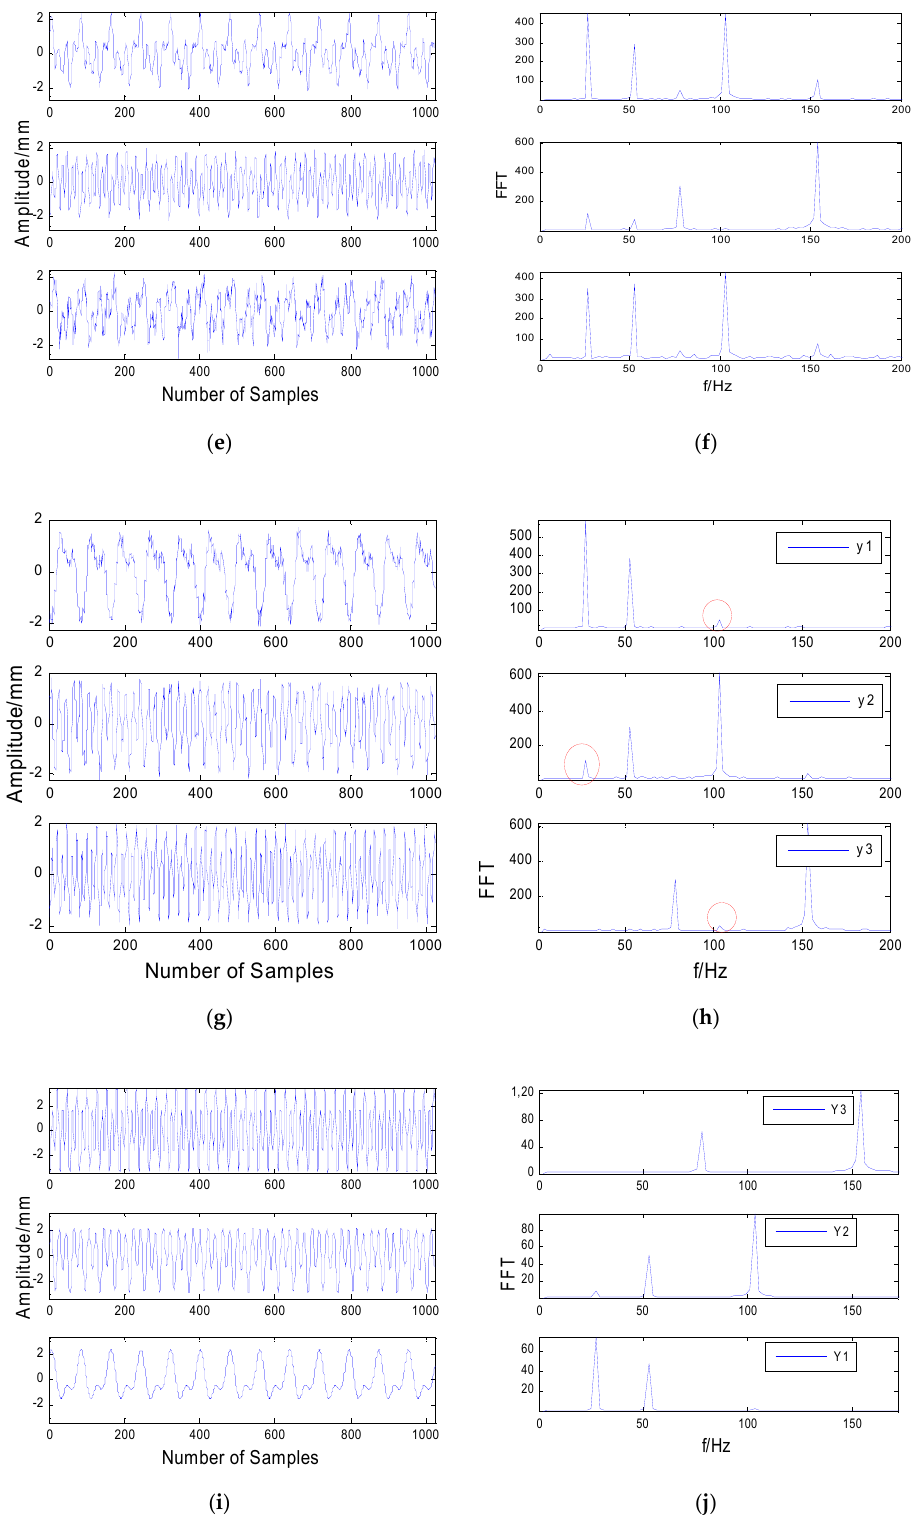
Figure 2. Simulation analysis of vibration signals with strong noises. ( a )The source signals in the time domain. ( b ) The source signals in the frequency domain. ( c ) The signals mixed noises in the time domain. ( d ) The signals mixed noises in the frequency domain. ( e ) The separated signals with noise by joint approximate diagonalization of eigenmatrices (JADE). ( f ) The separated signals with noise by JADE. ( g ) The separated signals by MF-FastICA. ( h ) The separated signals by MF-FastICA. ( i ) The separated signals by the MF-JADE method. ( j ) The separated signals by the MF-JADE